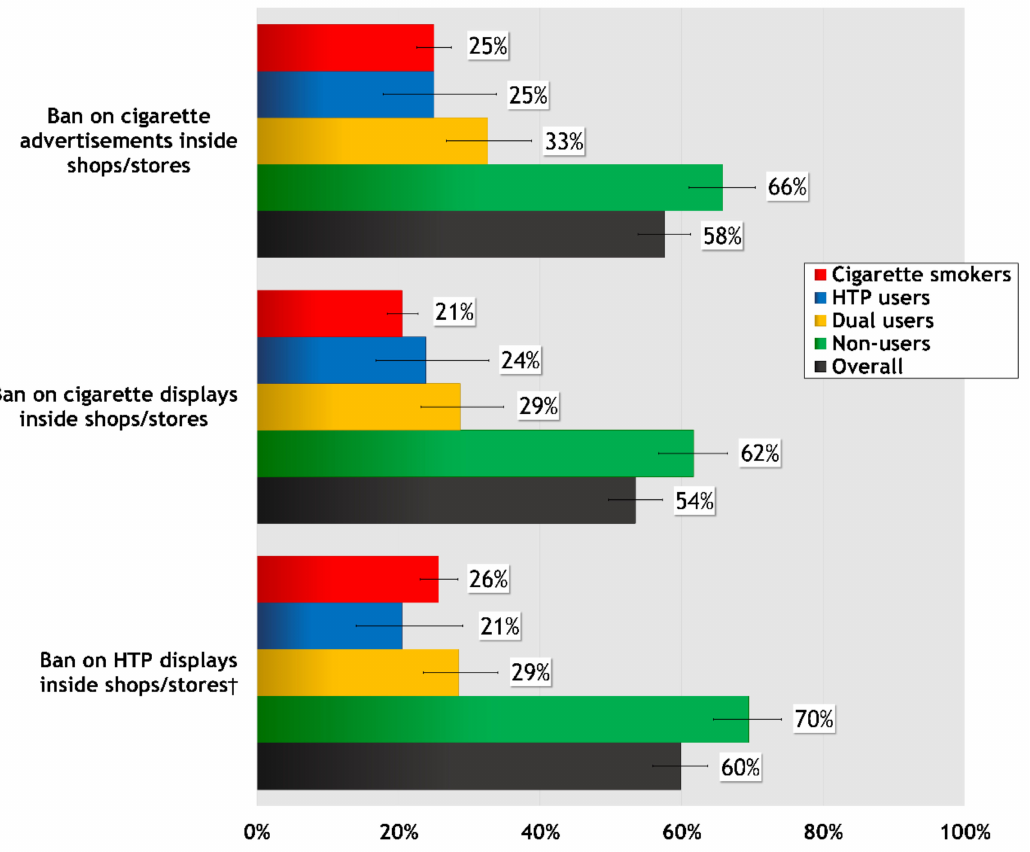
Figure 2. Percentage of Respondents who Support Tobacco Advertising, Promotion, and Sponsorship (TAPS) bans on HTPs and Cigarettes “Somewhat” or “A Lot”, Overall and by User Group. † This question was only asked to those who had ever heard of HTPs. Overall refers to the entire sample of